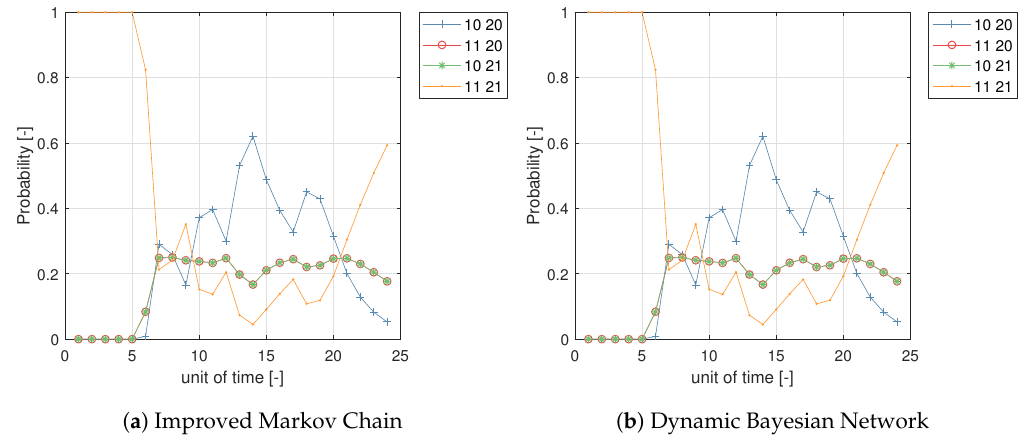
Figure 3. Network State Probability: One critical line with wind speed profile ‘A’.